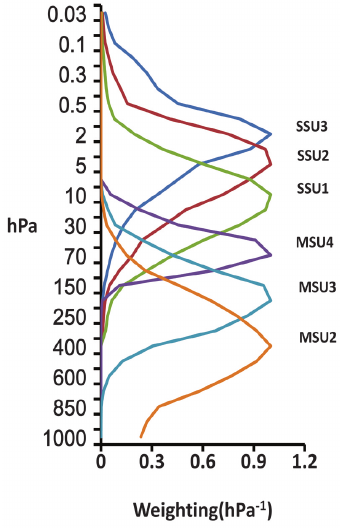
Figure 1. The weighting functions for the satellite Microwave Sounding Unit (MSU) and the Stratospheric Sounding Unit (SSU).